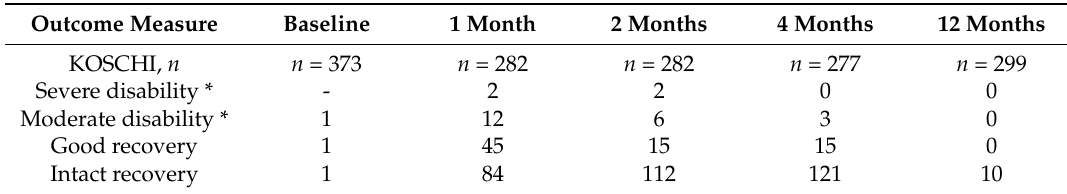
Table 4. KOSCHI categories for children aged 2–16 years at baseline, 1, 2, 4, and 12 months after injury ( n =